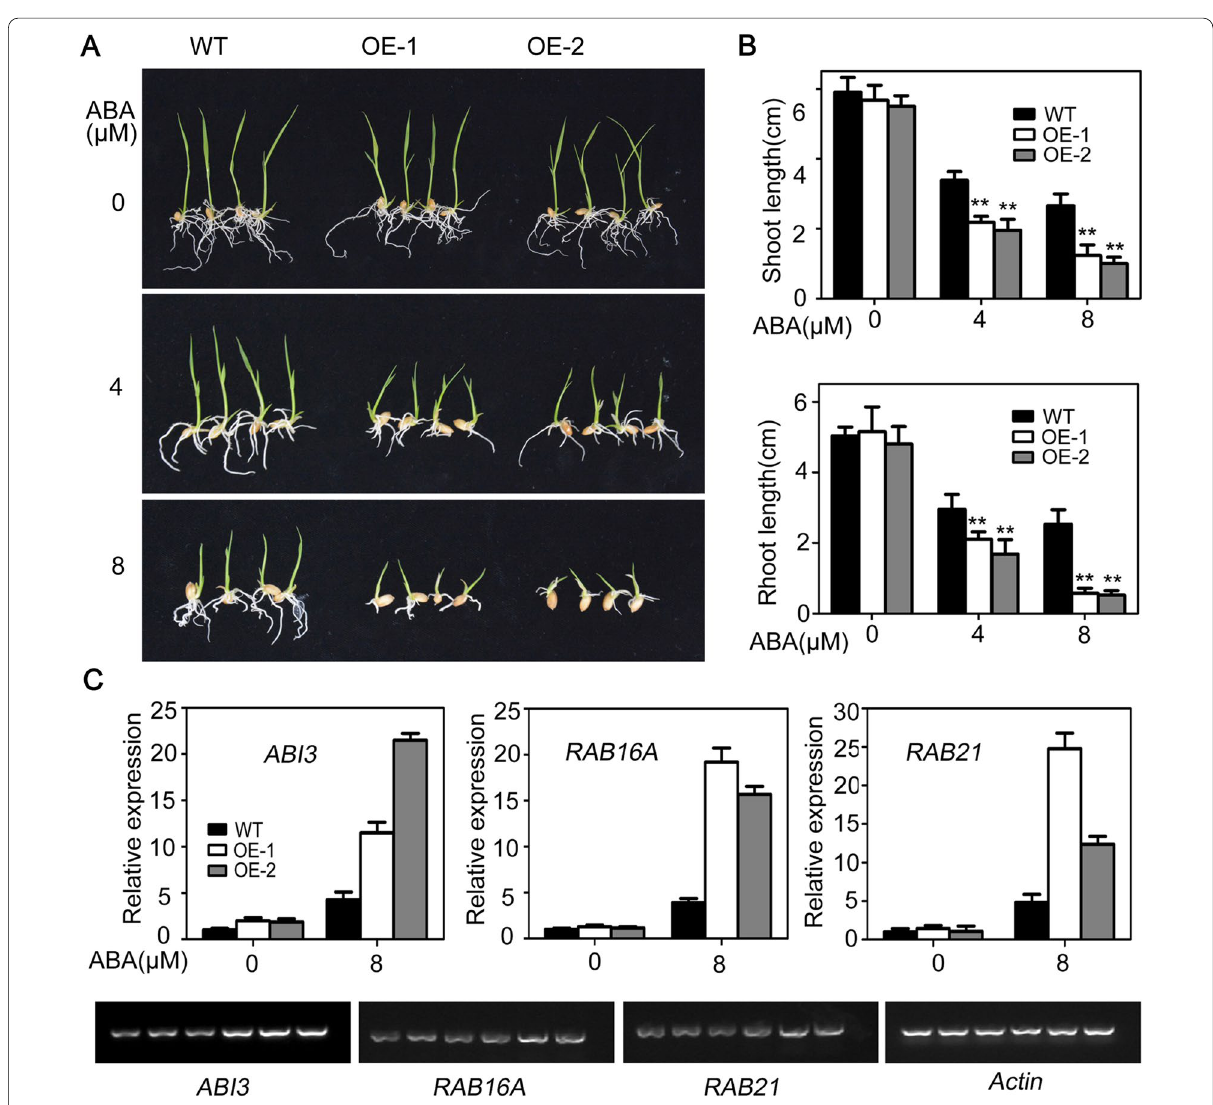
Fig. 3 Phenotypes of AtSOAR1 ‑transgenic plants in ABA‑induced early seedling growth arrest. A Phenotypic comparison of wild‑type and AtSOAR1 ‑transgenic plants OE‑1 and OE‑2 in ABA‑induced inhibition of seedling growth. Germinated seeds of different genotypes were cultured in ABA‑free (0 μM) or ( ) ABA‑containing (4 and 8 μM) solutions for 9 d before investigation. The experiments were repeated for three times and ± similar results were obtained. B Quantitative evaluation of shoot and root length of the wild‑type and transgenic plants as described in A . All the values are means SE from three independent biological determinations. Student’s t test was used for comparing the shoot length or root length ± of each overexpression line with those of wild‑type plants (with significant differences at ** P < 0.01). C Detection of ABA‑responsive genes in wild‑type and AtSOAR1 ‑transgenic lines by qPCR and semi‑quantitative RT‑PCR. The bands from left to right indicates WT without treatment, OE‑1 without treatment, OE‑2 without treatment, ABA‑treated WT, ABA‑treated OE‑1 and ABA‑treated OE‑2, respectively. Materials described in A was sampled for total RNA extraction and cDNA synthesis. Actin1 was used for internal control and all the values are means biological